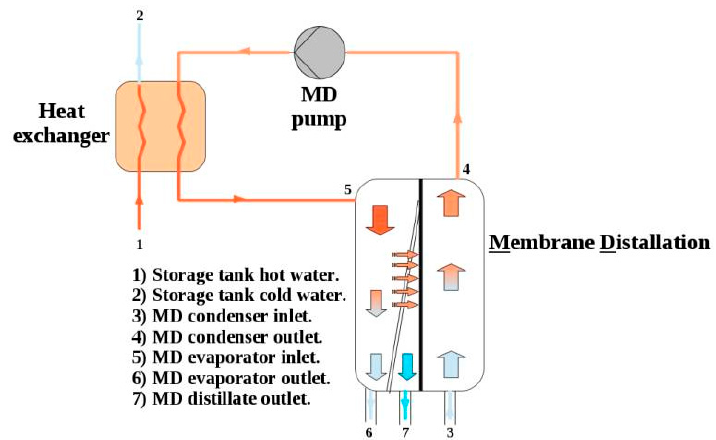
Figure 2. MD basic principle of operation.